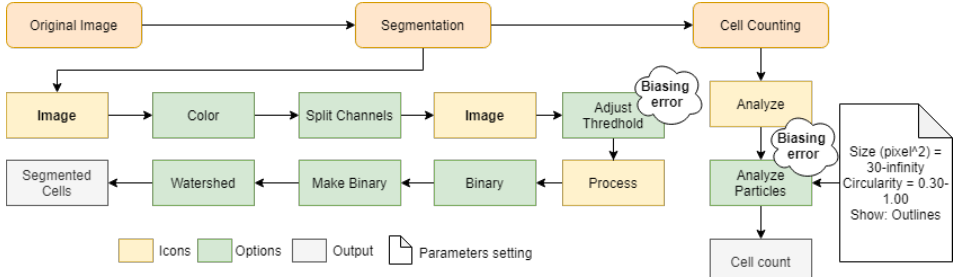
Figure 10. Schematic diagram of procedure followed by ImageJ software for segmentation and quantification of HCT-8 and NIH3T3